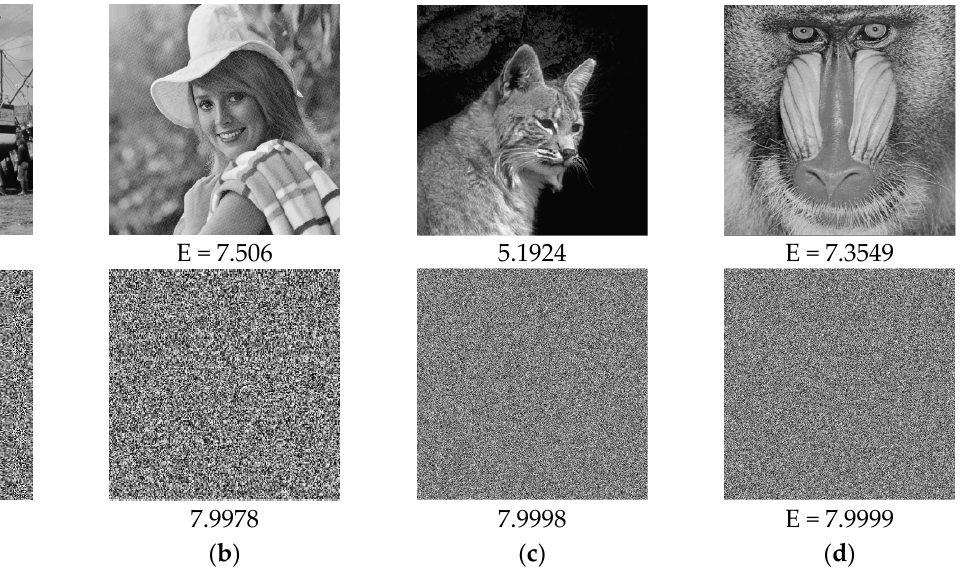
Figure 21. Test images of sizes ( a , b ) 256 × 256, ( c , d ) 512 × 512 and their encrypted versions through the proposed scheme with the corresponding entropy values.